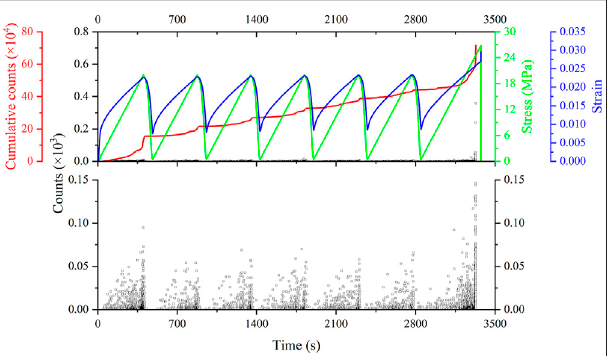
Frontiers in Earth Science |